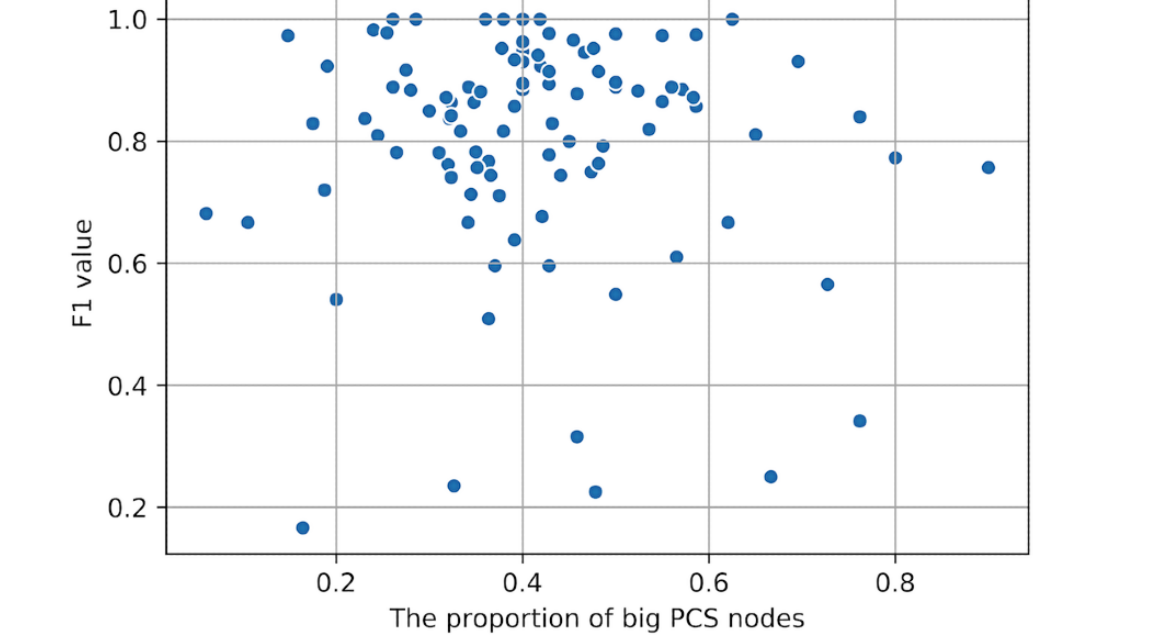
Table 3. The parallel concept set (PCS) thread-based algorithm versus the primitive pairwise-based algorithm on the “First Rib” case, using different models.